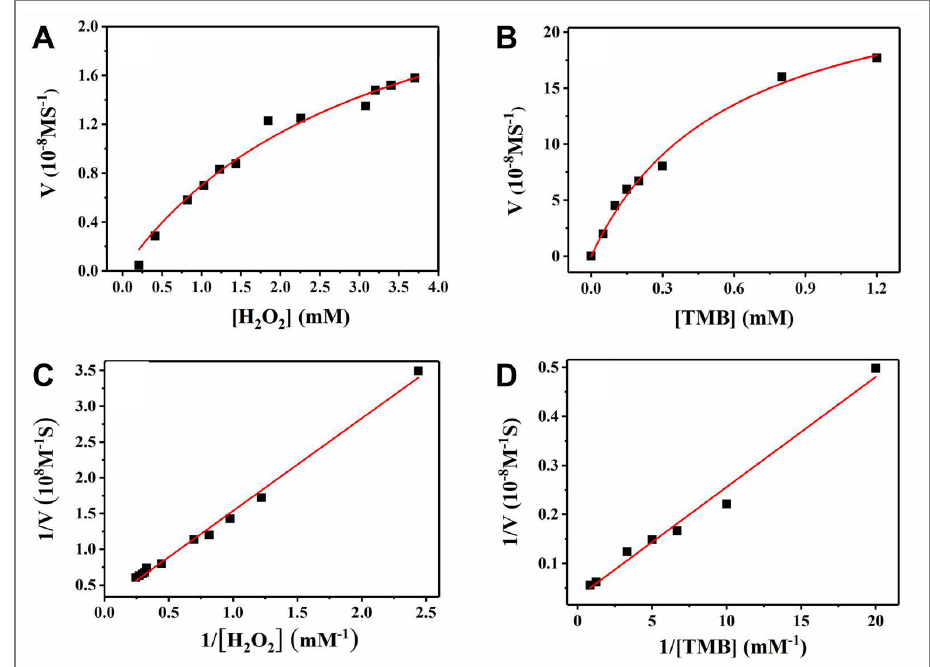
Figure 3. The kinetic process of 60 µg/mL CuS to 0.8 mM TMB and different concentrations of H 2 O 2 ( A ), as well as to 0.12 mM H 2 O 2 and different concentrations of TMB ( B ) at 37 °C for 20 min; The relevant Lineweaver-Burk plots for the H 2 O 2 ( C ) and the TMB ( D ).